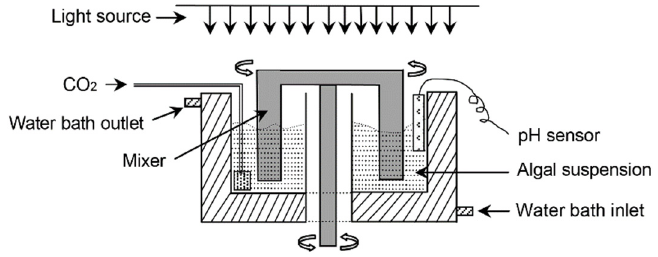
Figure 1. Scheme of the circular photobioreactor.